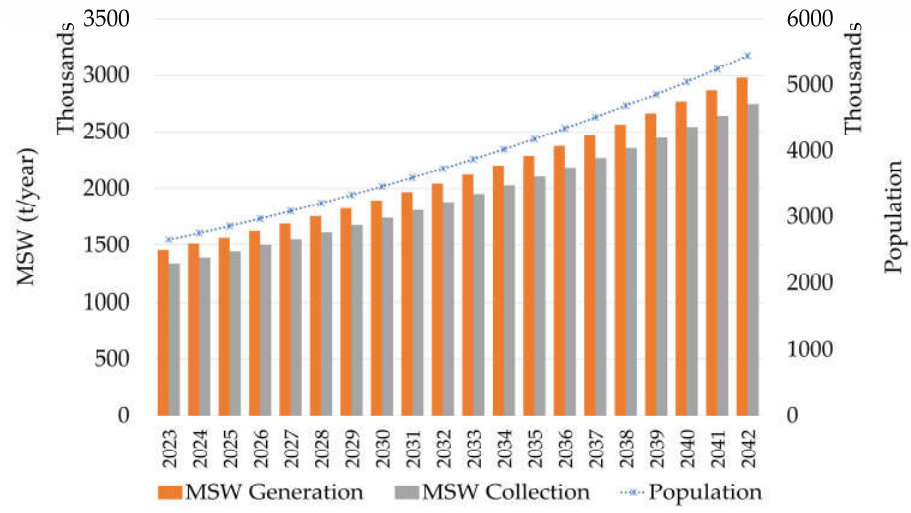
Figure 2. MSW projection for Phnom Penh municipality from 2023 to 2042.